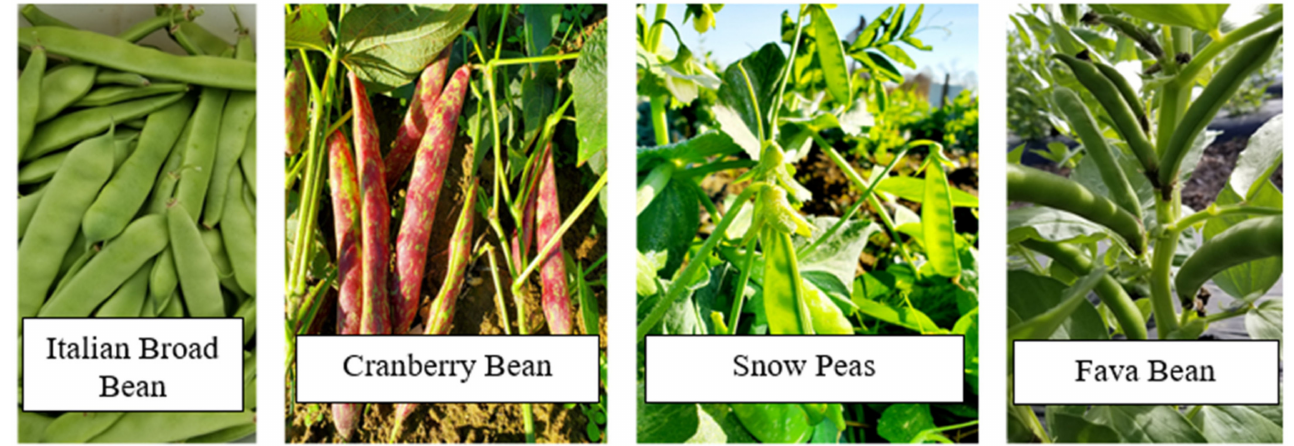
Figure 3. Some ethnic legumes cultivated at Specca Farms Pick-Your-Own, Bordentown, New Jersey. These crops are cross-cultural in